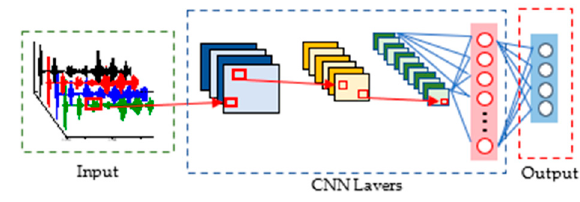
Figure 9. Flowchart for the damage detection by CNN.